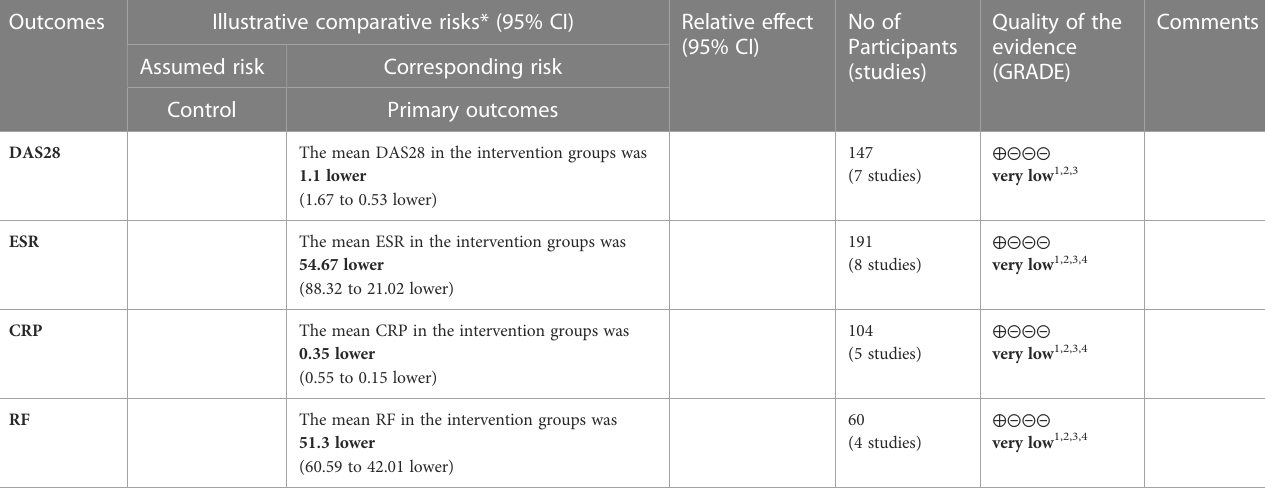
TABLE 5 The evidence quality of